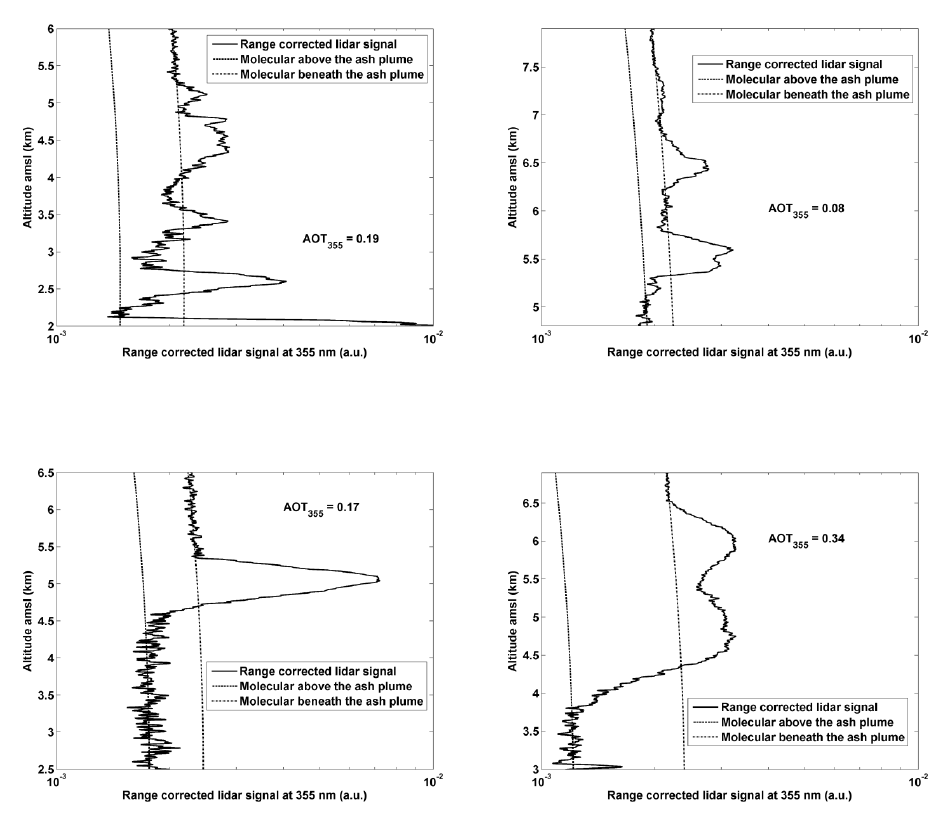
Figure 8: Range-corrected lidar signal on 12 and 16 May 2010: top-left panel for the plume of 12 May ( − 19.545 ◦ E 44.849 ◦ N, 16:27 GMT), top-right panel for the plume crown of 12 May ( − 18.532 ◦ E 44.860 ◦ N, 16:15 GMT), bottom-left panel for the filament of 12 May ( − 11.098 ◦ E 43.851 ◦ N, 15:30 GMT), and bottom-right panel for the plume of 16 May ( − 1.706 ◦ E 53.858 ◦ N, 18:42 GMT). The molecular contributions have been simulated for each normalization altitude, and are also given in each figure.